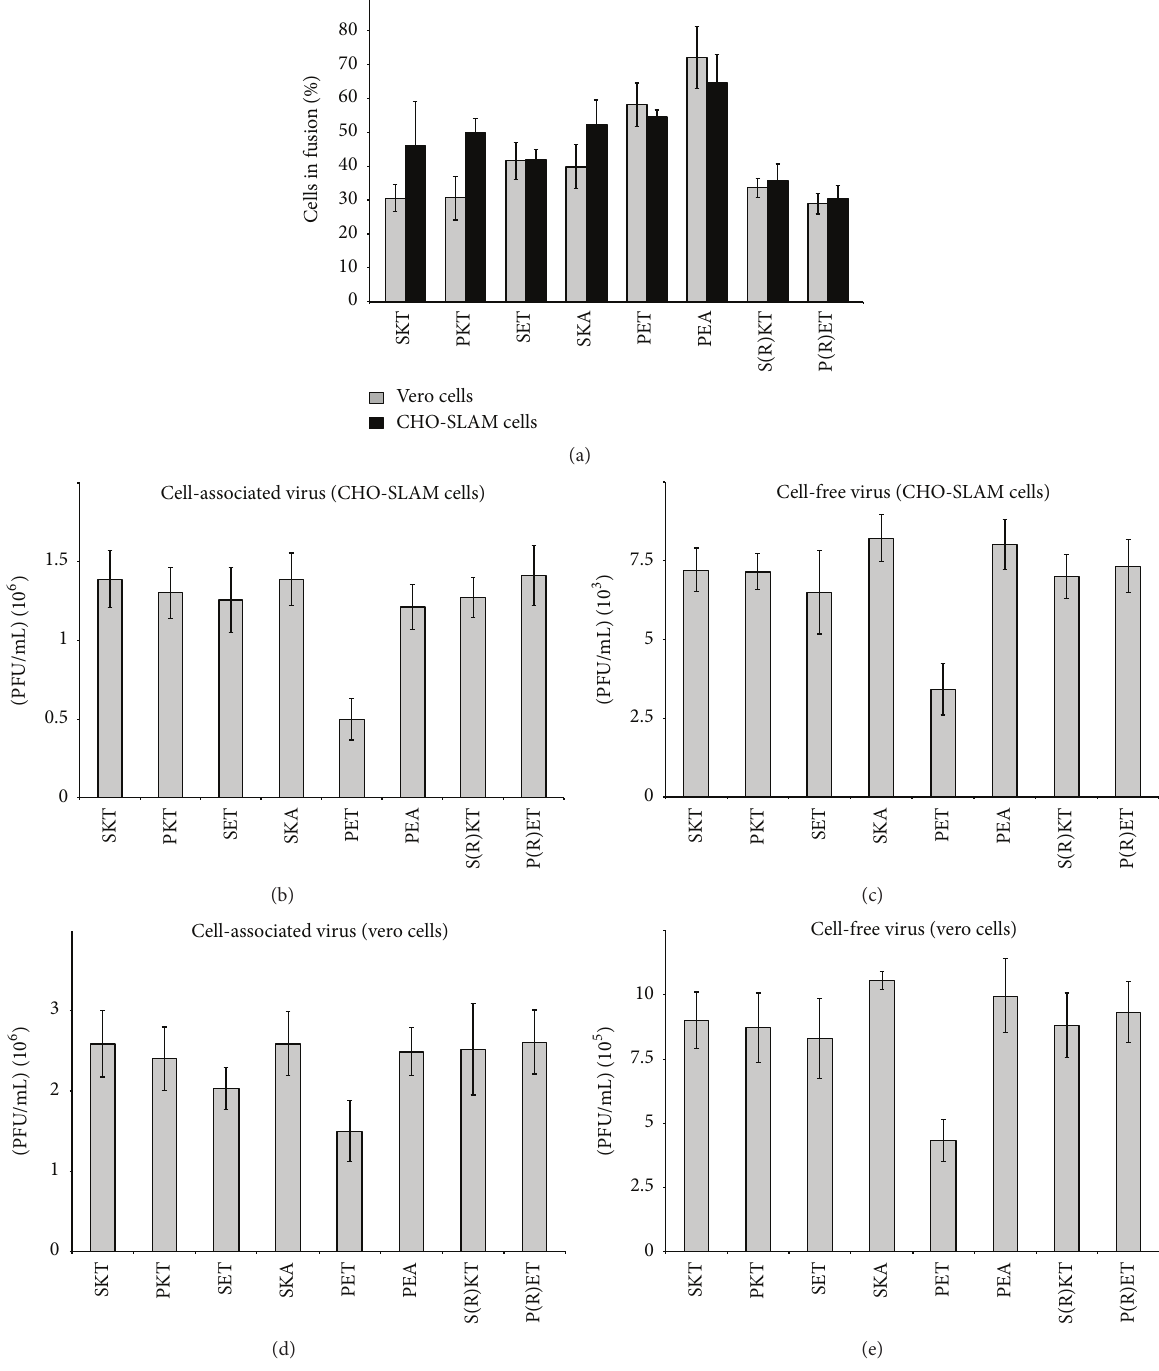
Figure 4: Assay of Moraten strain recombinants cell-cell fusion and virus assembly capacities. Vero cells and CHO-SLAM cells infected with Moraten recombinants were analysed 30 h and 48 h after infection for their cell-cell fusion and virus assembly capacities, respectively. Histogram data represent the mean percentages ± standard deviations for three experiments. (a) CD46- and SLAM-dependent fusion; ((b) and (c)) SLAM-dependent production of cell-associated and cell-free virus, respectively; ((d) and (e)) CD46-dependent production of cell- associated and cell-free virus,